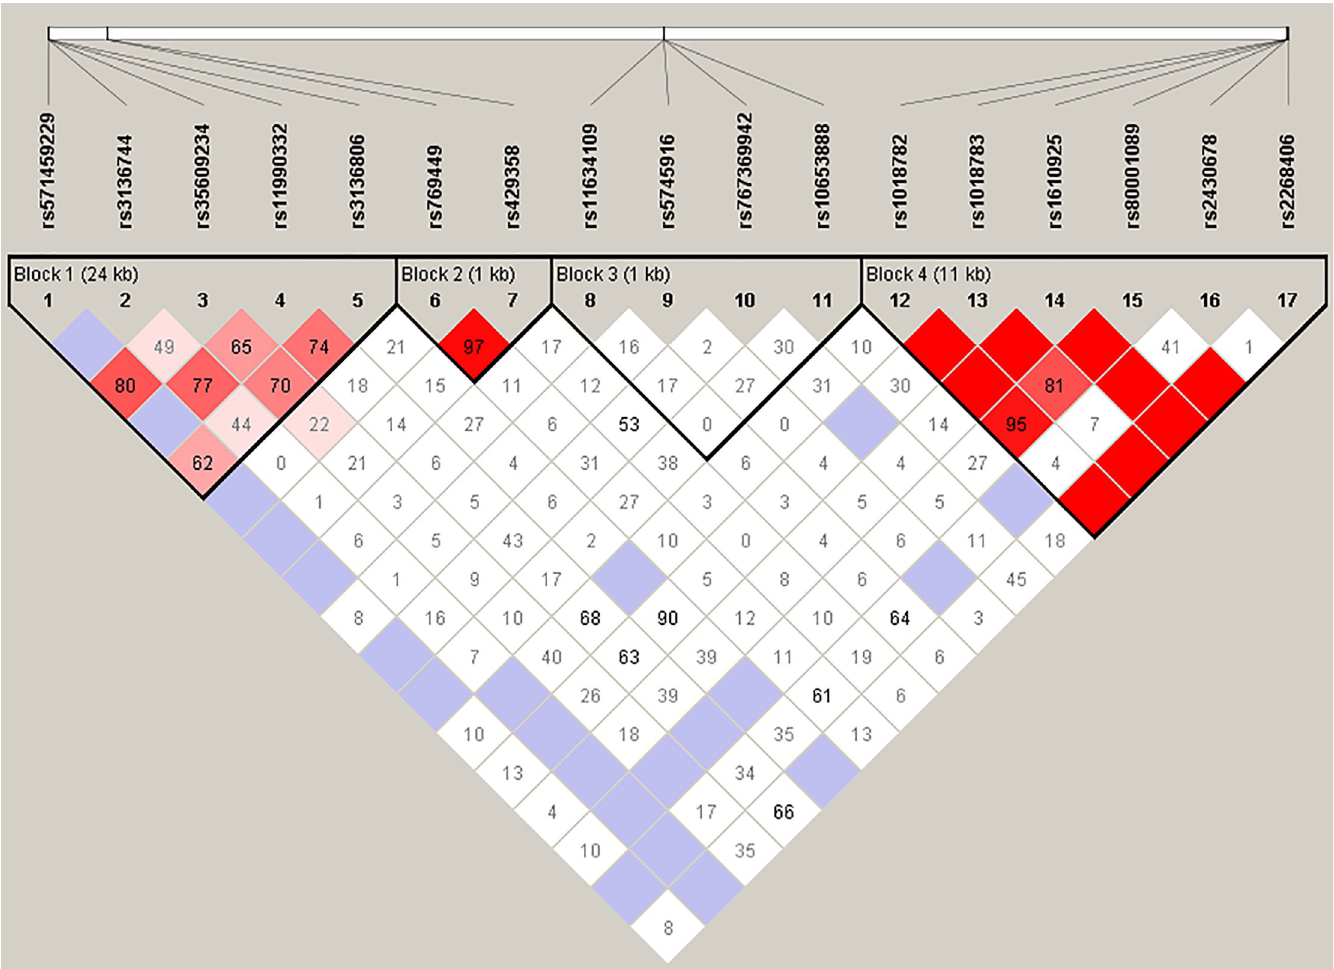
(Table 3) with APOE ε 4 carriers or non-carriers in LOAD case-control status (Table 7). Indi-